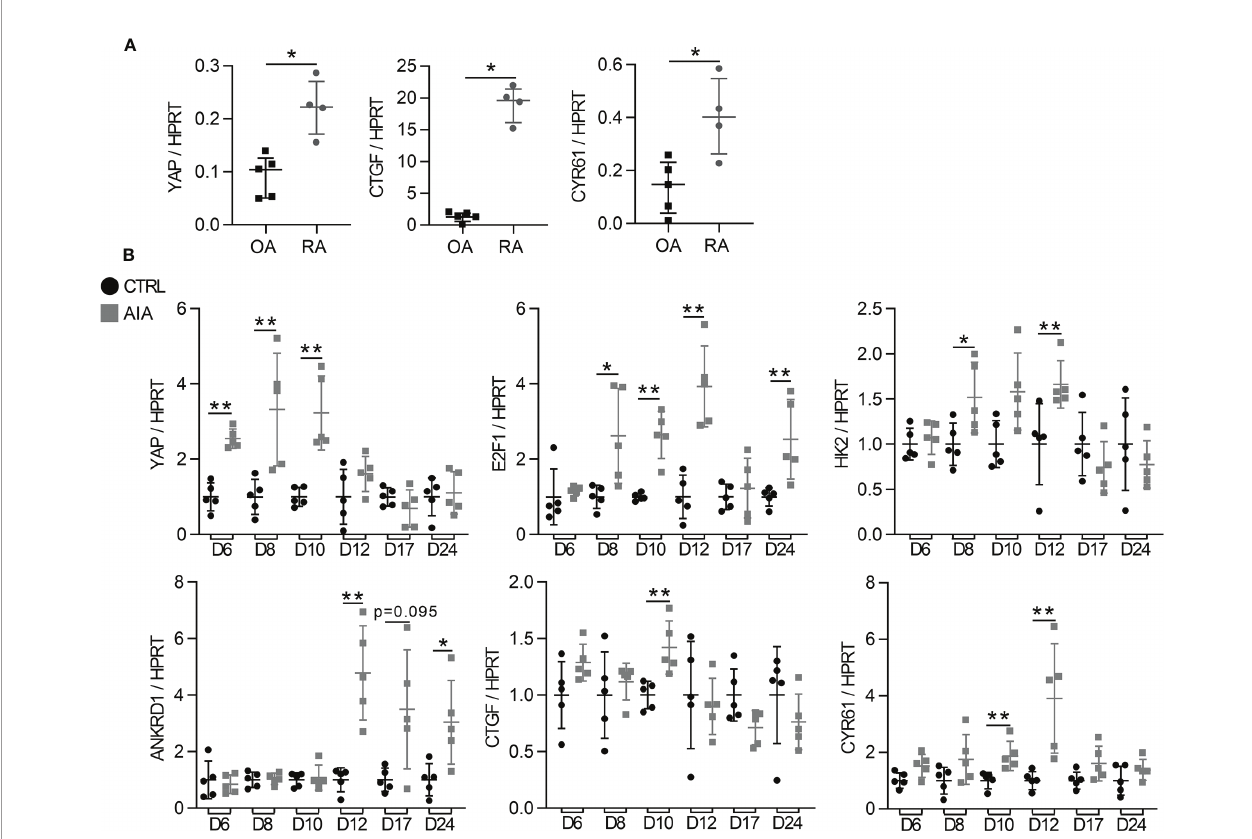
FIGURE 1 | High YAP/TAZ transcriptional activity during arthritis (A) RT-qPCR quanti fi cation of YAP, CTGF and CYR61 expression normalized to HPRT expression in synovial organoids at 21 days of culture. Organoids (n=12 to 15) were formed with FLS from one rheumatoid arthritis (RA) and one osteoarthritis (OA) patient. Each point represents three organoids that were mixed for RNA extraction. (B) RT-qPCR results of mRNA from the ankle of adjuvant induced arthritis (AIA) and control (CT) rats. Results were normalized to HPRT expression and expressed as fold change vs. CT at each day. Rats were sacri fi ced at different times (n=5) with an arthritis onset observed at day 10. Data were presented as individual values with median and interquartile range. Mann-Whitney tests were used. D, day post induction; YAP, yes-associated protein; HPRT, hypoxanthine phosphoribosyltransferase; CTGF, connective tissue growth factor; CYR61, cysteine-rich angiogenic inducer 61; E2F1, E2F transcription factor1; HK2, hexokinase2; ANKRD1, ankyrin repeat domain-containing protein1; *p < 0.05; **p <